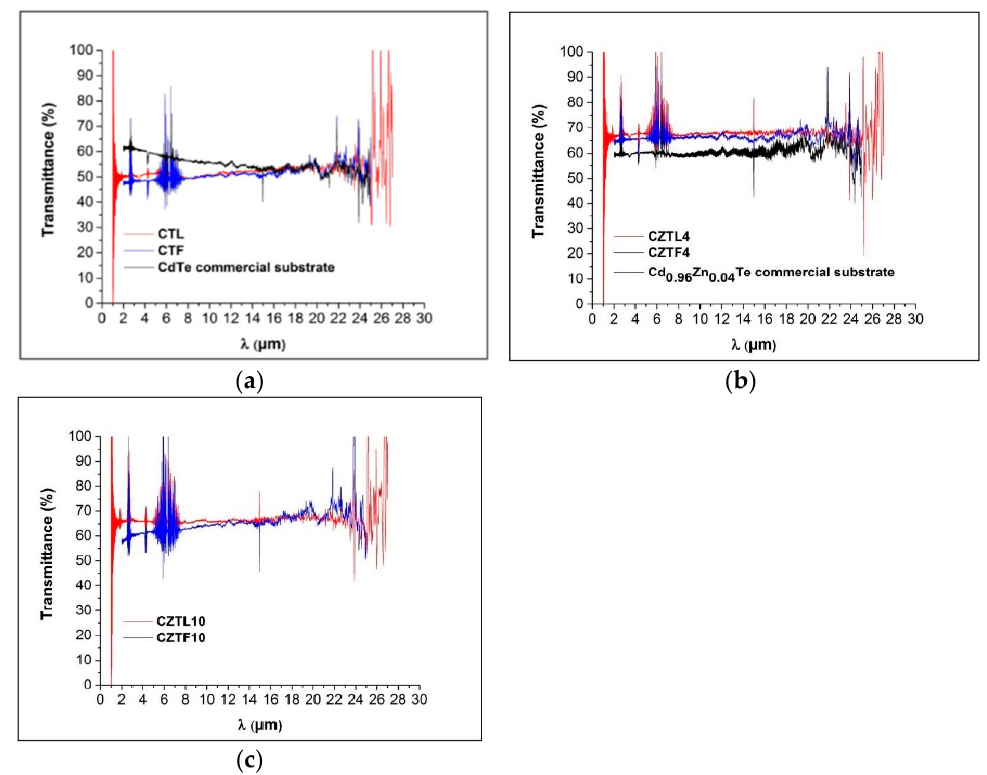
Figure 10. Optical transmission of: ( a ) CdTe; ( b ) Cd 0.96 Zn 0.04 Te; and ( c ) Cd 0.90 Zn 0.10 Te.